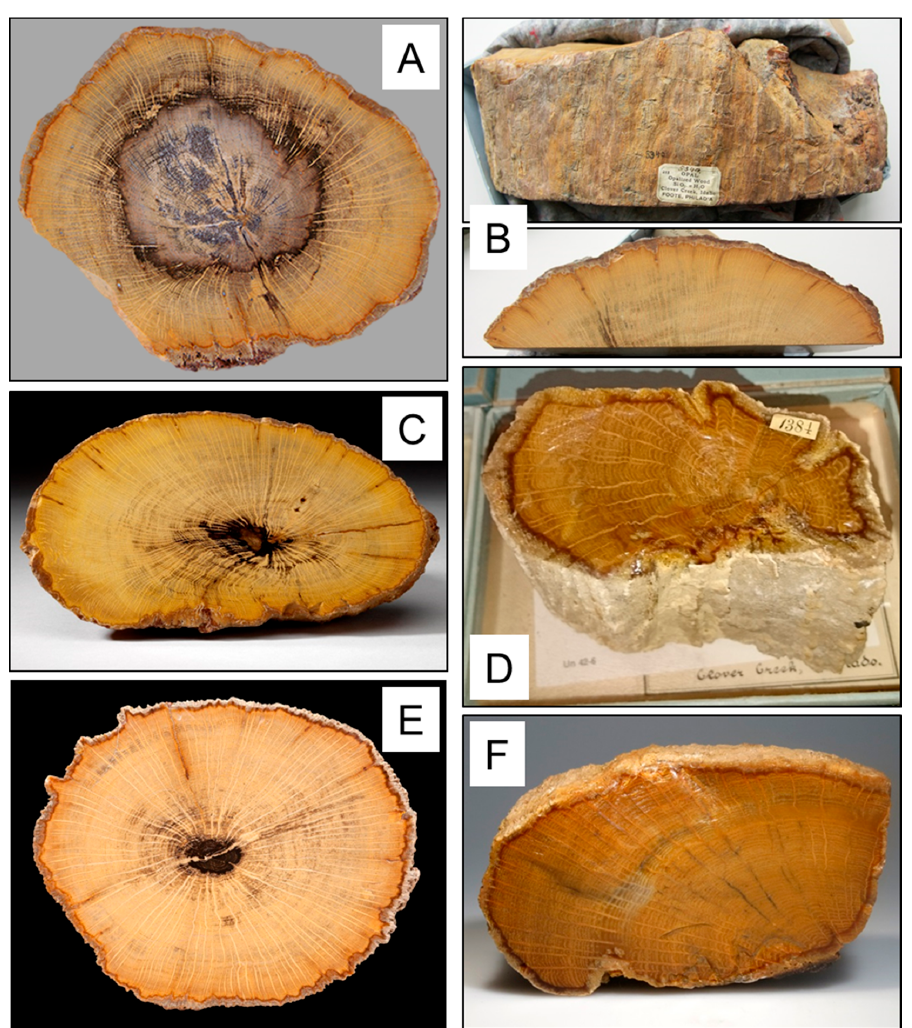
Figure 1. Opalized wood from C+bblover Creek, Idaho. ( A ) Specimen at School of Mines, Golden,